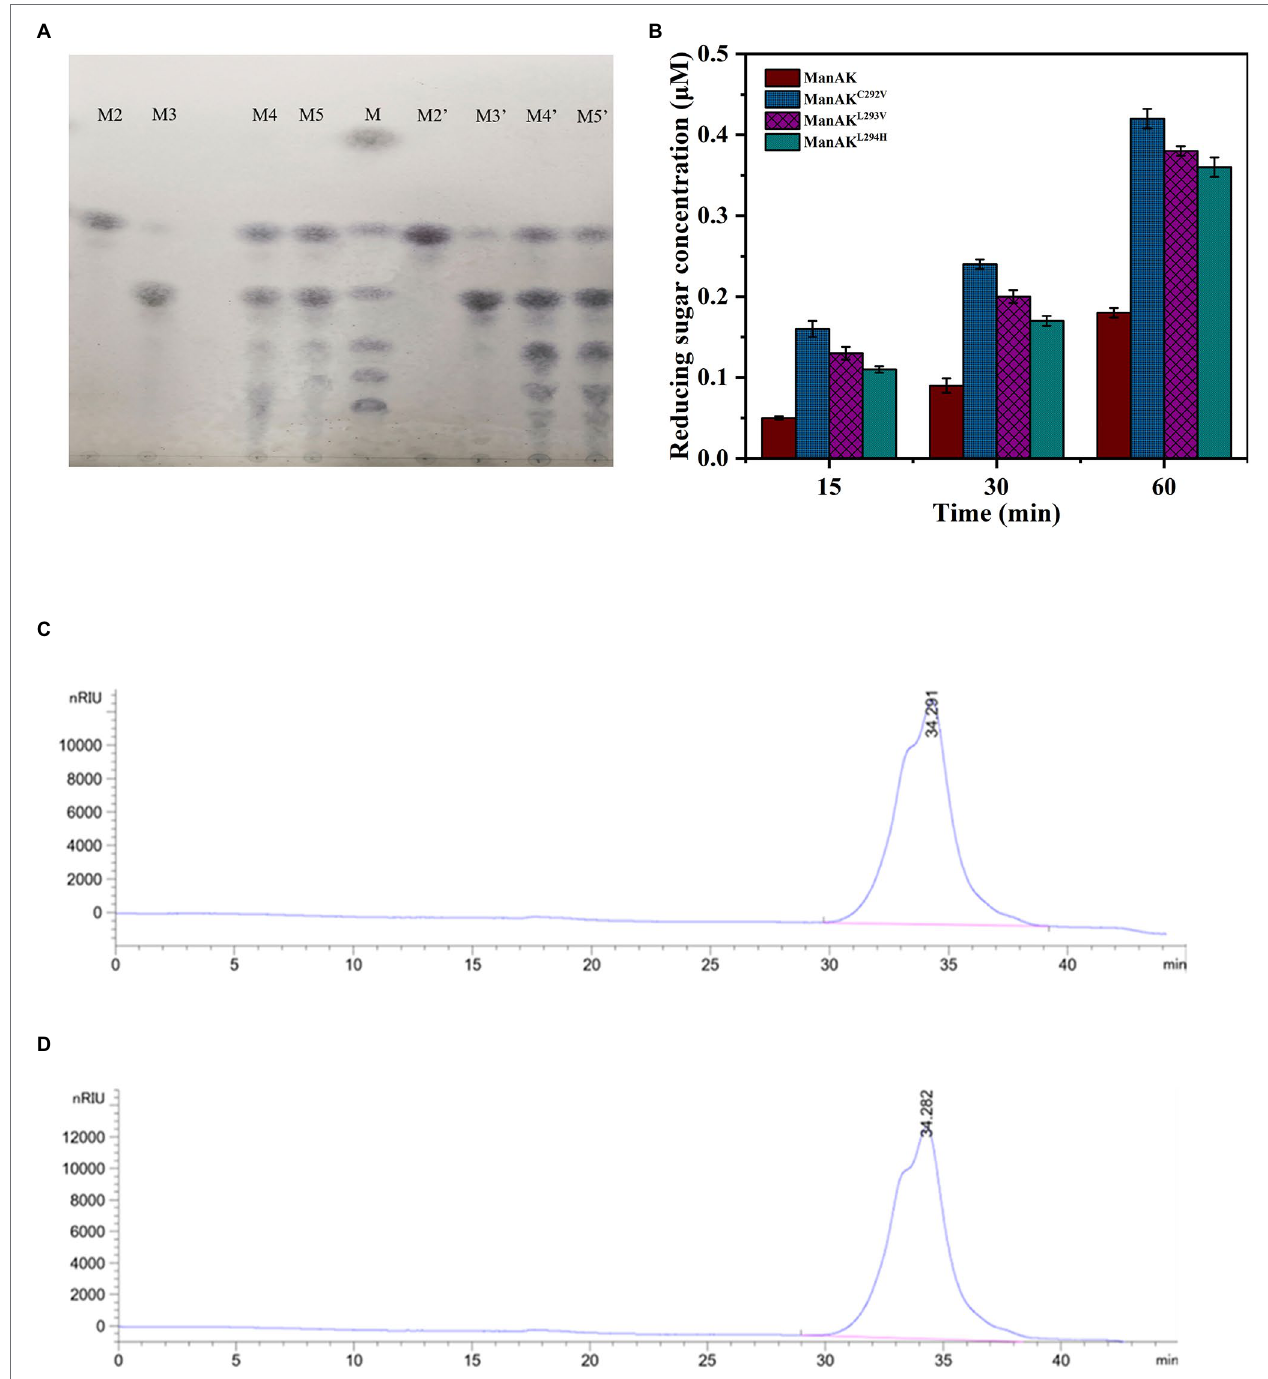
FIGURE 4 | Analysis of hydrolysis products. (A) The hydrolysis of substrates by ManAK and ManAK L293V , and thin-layer chromatography (TLC) analysis of hydrolysis products from manno-oligosaccharides (MOS) standards (M2–M5). The reaction was carried out at 37 ° C for 10 min, and the reactants were 5 U purified enzyme and 20 mM MOS standard solution. Lanes: (M) the MOS standards consist of mannose, mannobiose, manninotriose, mannotetrose, mannopentose, and mannohexose (from top to bottom; M2–M5) the hydrolysis products of mannobiose, manninotriose, mannotetrose, and mannopentose, respectively, (M2’–M5’) the same indication as above, analysis of hydrolysis products of ManAK L293V . (B) The release of reducing sugar concentration of recombinant mannanases incubated with D-mannan in 50 mM sodium acetate buffer (pH 5.5) at 37 ° C. (C) High-performance liquid chromatography (HPLC) analysis of the molecular weight distribution of hydrolysis products from locust bean gum (LBG) by ManAK (reaction carried out at 37 ° C for 12 h). (D) HPLC analysis of the molecular weight distribution of hydrolysis products from LBG by ManAK L293V (reaction carried out at 37 ° C for 12